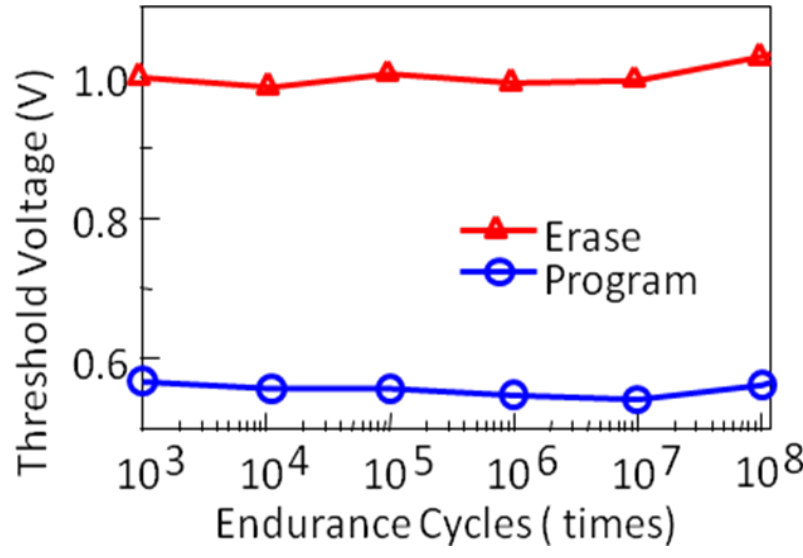
Figure 11. Program/erase endurance characteristics up to 10 8 cycles of a FeNAND memory cell. Reproduced from [41] with permission of IEEE.